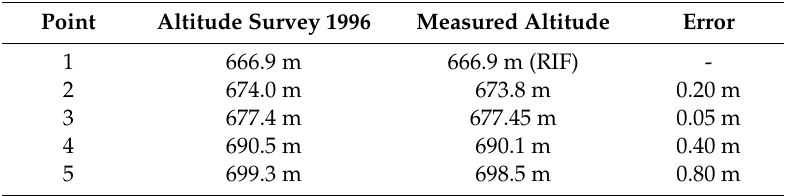
Table 4. Altitude comparison between the CPs.